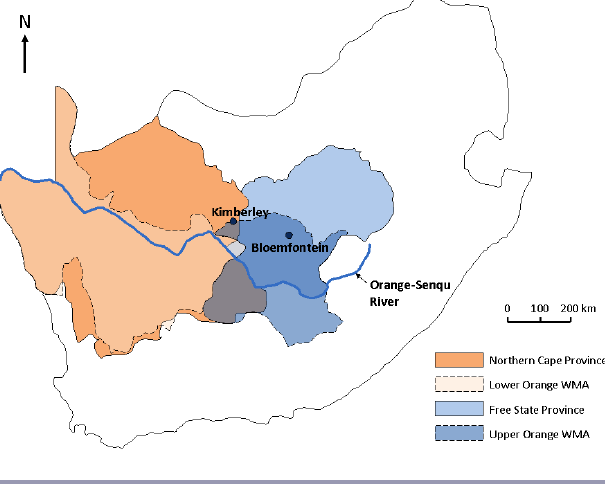
Fig. 1. Mismatch of hydrological and administrative boundaries in the Upper and Lower Orange Water Management Areas